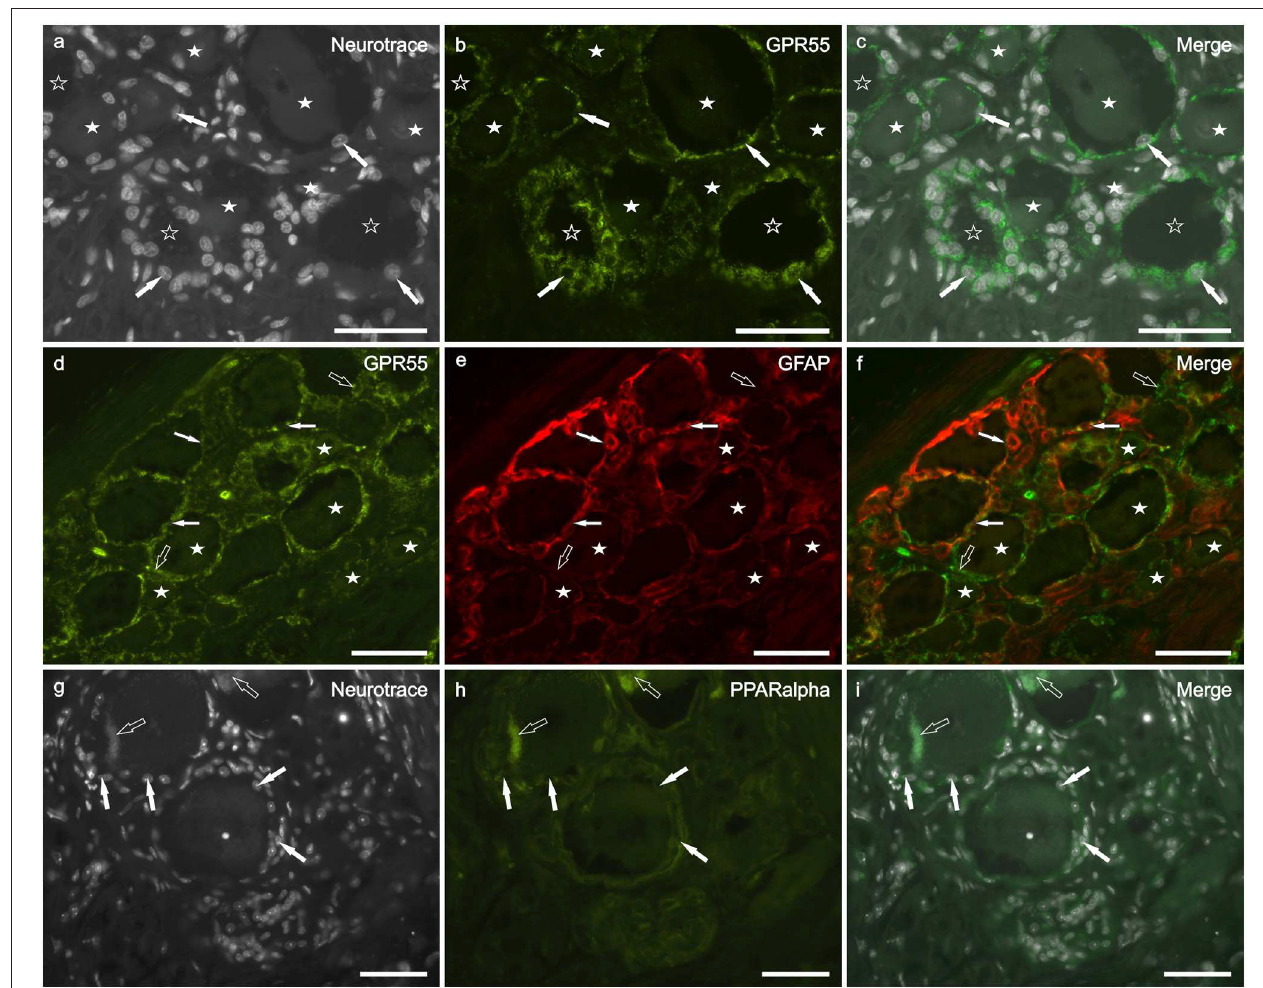
FIGURE 4 | Photomicrographs of cryosections of canine cervical (C8) dorsal root ganglion showing GPR55 (a–f) and PPARalpha (g–i) immunolabeling. (a–c) Arrows indicate the Neurotrace-labeled nuclei of satellite glial cells (a) which showed bright GPR55 immunolabelling (b) . White stars indicate unlabeled sensory neurons; open stars indicate empty spaces in which sensory neurons were no more evident. (d–f) White arrows indicate satellite glial cells which co-expressed bright GPR55- (d) and glial fibrillary acidic protein (GFAP) immunoreactivity; open arrows indicate SGCs which were GPR55 immunoreactive and GFAP negative (e) . Stars indicate sensory neurons of different dimension, which expressed faint –to-moderate GPR55 immunoreactivity. (g–i) White arrows indicate the Neurotrace labeled nuclei of SGCs which showed PPARalpha immunoreactivity (h) . Open arrow indicate autofluorescent pigment. Bar: a–i = 50 µ